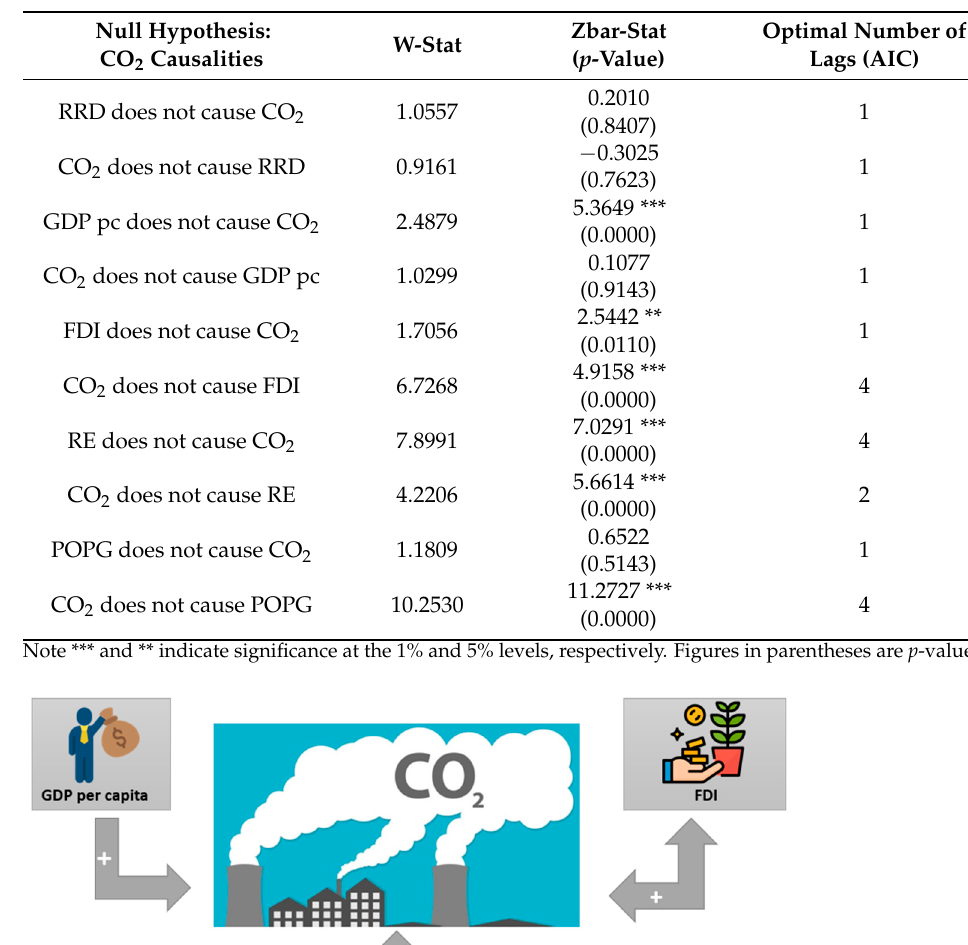
Table 6. Dumitrescu and Hurlin’s noncausality test.